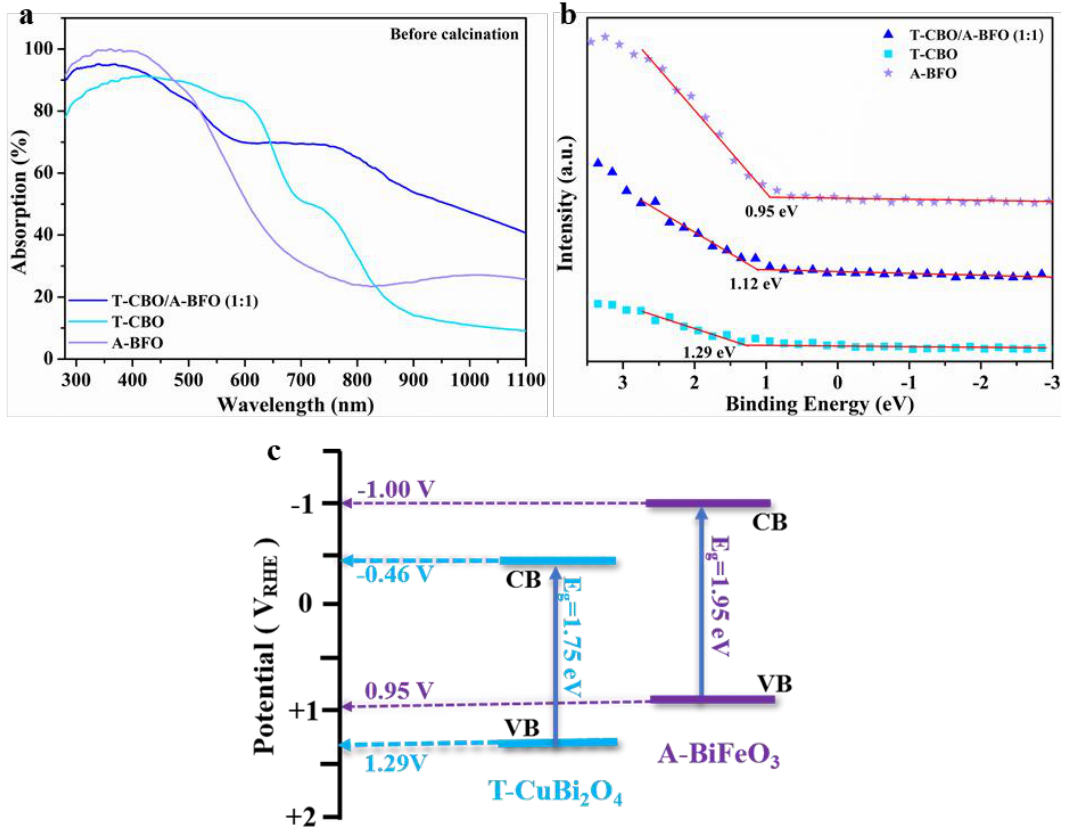
Figure 6. ( a ) UV-vis di ff use reflectance spectra; ( b ) XPS VB spectra of the T-CBO, A-BFO and T-CBO / A-BFO (1:1); ( c ) schematic energy band